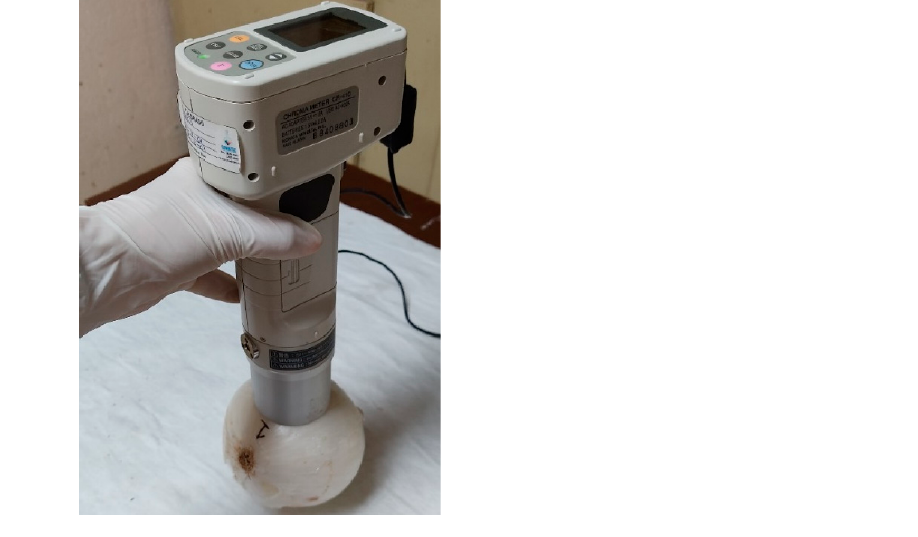
Figure 1. Measurement of onion color using a chroma meter CR-410 (Konica Minolta, Inc, Japan).